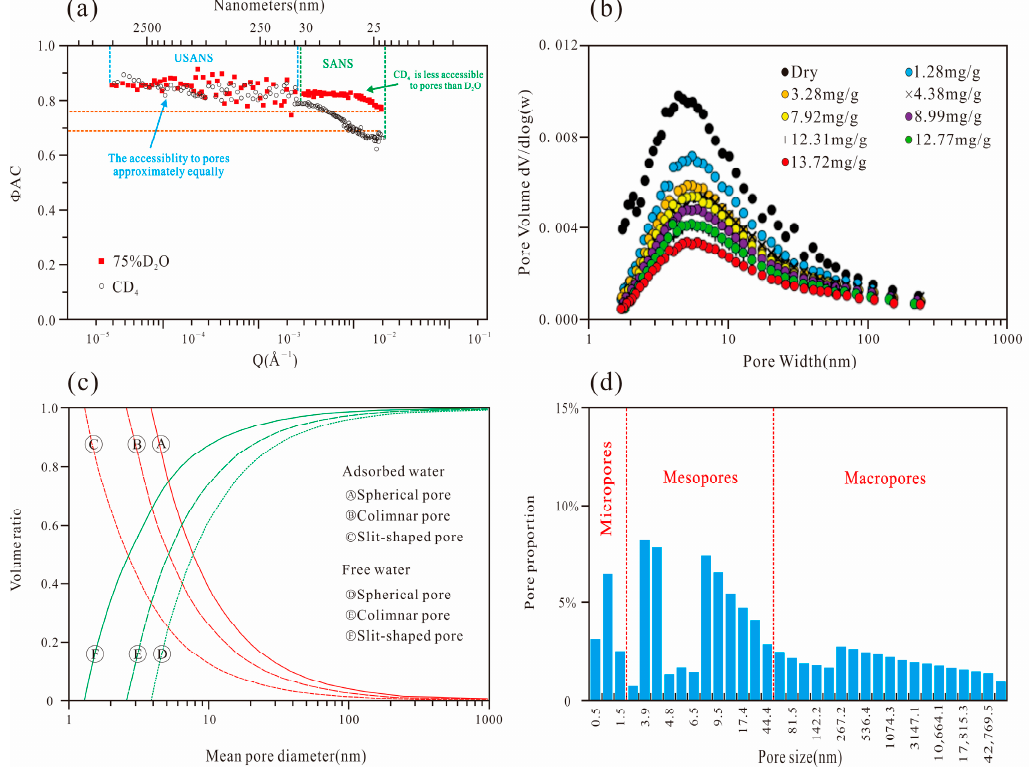
Figure 9. ( a ) Comparison between deuterated water (D 2 O) and deuterated methane (CD 4 ) based on their access to pores in shale samples. Φ AC is the proportion of accessible pores, and Q is the small-angle scattering vector. Barnett shale, Fort Worth Basin, Texas, USA. The figure is modified from [196]. ( b ) Pore size distribution of shale samples with different adsorbed moisture contents. Lower Cambrian shale, Guizhou, China. The figure is from [64]. ( c ) The distribution characteristics of adsorbed water and free water in pores of different shapes in shale. The volume ratio is the ratio of adsorbed water volume or free water volume to the total water volume. Longmaxi shale, Sichuan Basin, China. The figure is from [122]. ( d ) The distribution of adsorbed water in full-sized pores under conditions where the water saturation is below the critical level of water saturation. The ordinate is the ratio of pores of specific sizes which are occupied by water to the total pore volume occupied by water. The mesopores have a stronger water adsorption capacity. Longmaxi shale, Sichuan Basin, China. The figure is from [29].